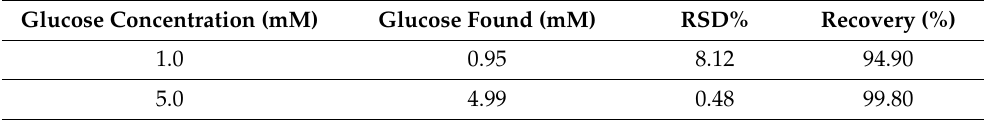
Table 2. Recovery tests results (n = 3